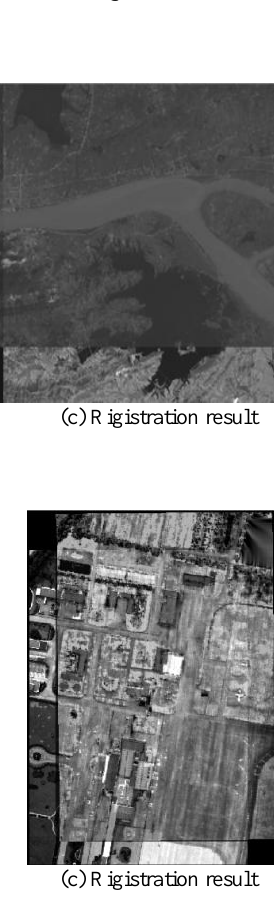
Figure 6: Image registration from test set